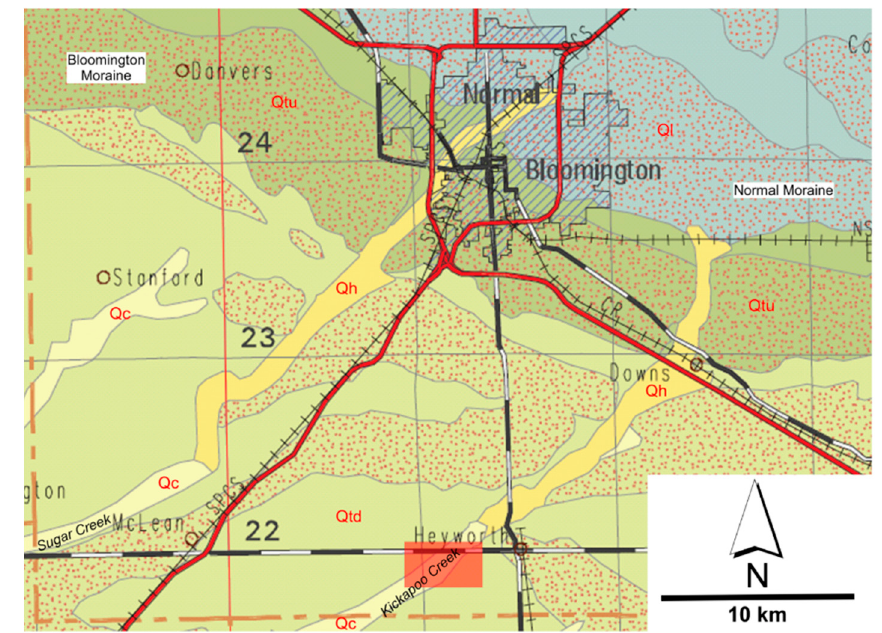
Figure 2. Surficial geologic map of southern McLean County, IL (modified from Stiff et al. [9]). This area is dominated by Wisconsin age glacial deposits that form recessional moraine and till plain landforms. Qtd = Tiskilwa Formation, Delavan Member, Qh = Henry Formation. The area of Figure 3A is indicated by the red box.